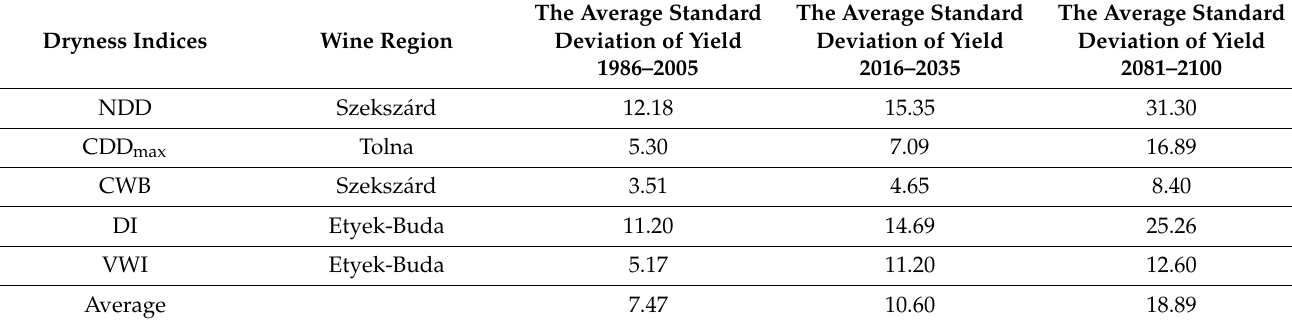
Table 8. Values of standard deviations of simulated wine grape yields were produced based on the regression coefficients of the best regression fits of dryness indices in different 20-year periods. Significant differences are set in italic. All selected dryness indices initiate significant variability for the distant future, whereas only the VWI increases the variance significantly in the near